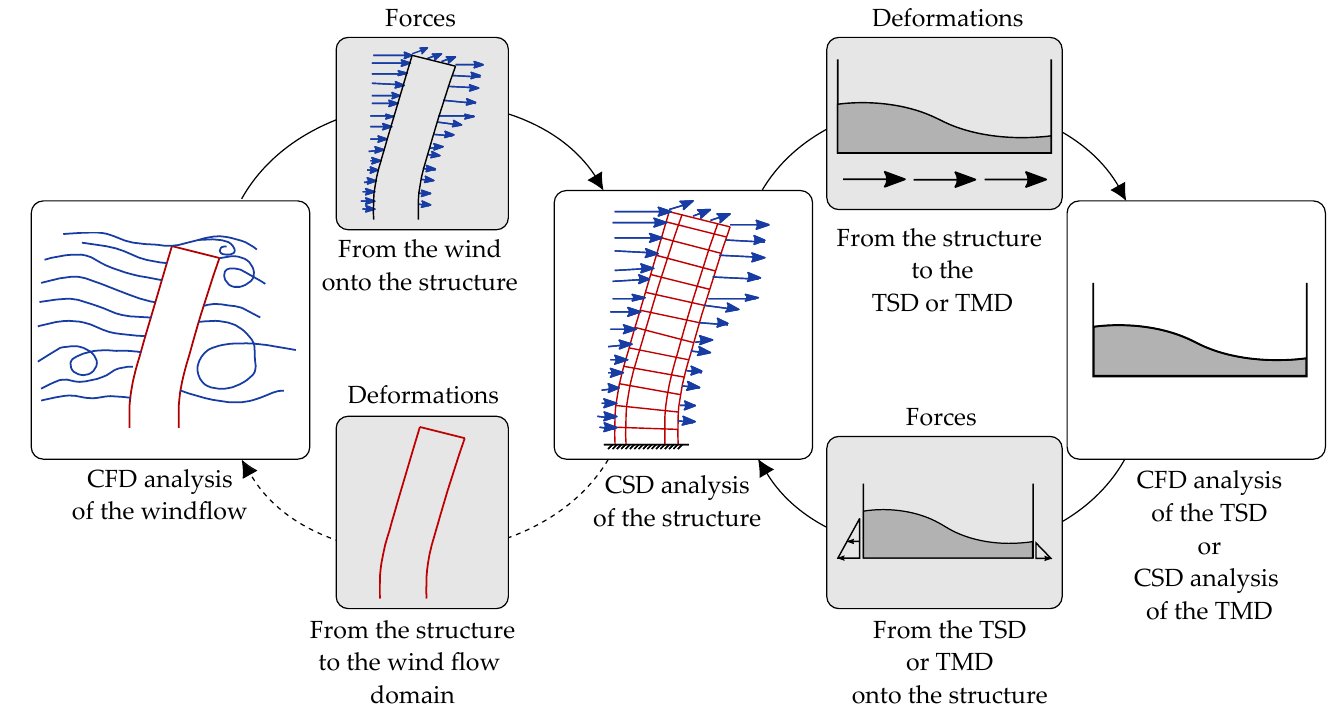
Figure 9. Representation of the coupled wind–structure–damper